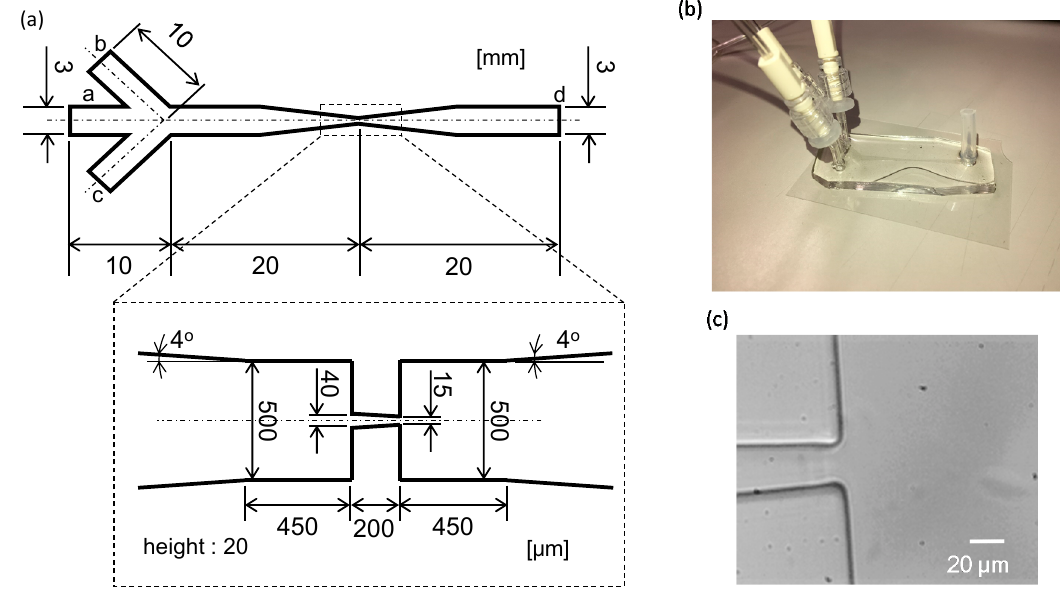
Figure 1. ( a ) Schematic drawing of the microflow channel—a, inlet port for cell flow; b and c, inlet ports for sheath flow; and d, outlet. ( b ) A fabricated microfluidic device and ( c ) a magnified view of the tip of the microflow channel.